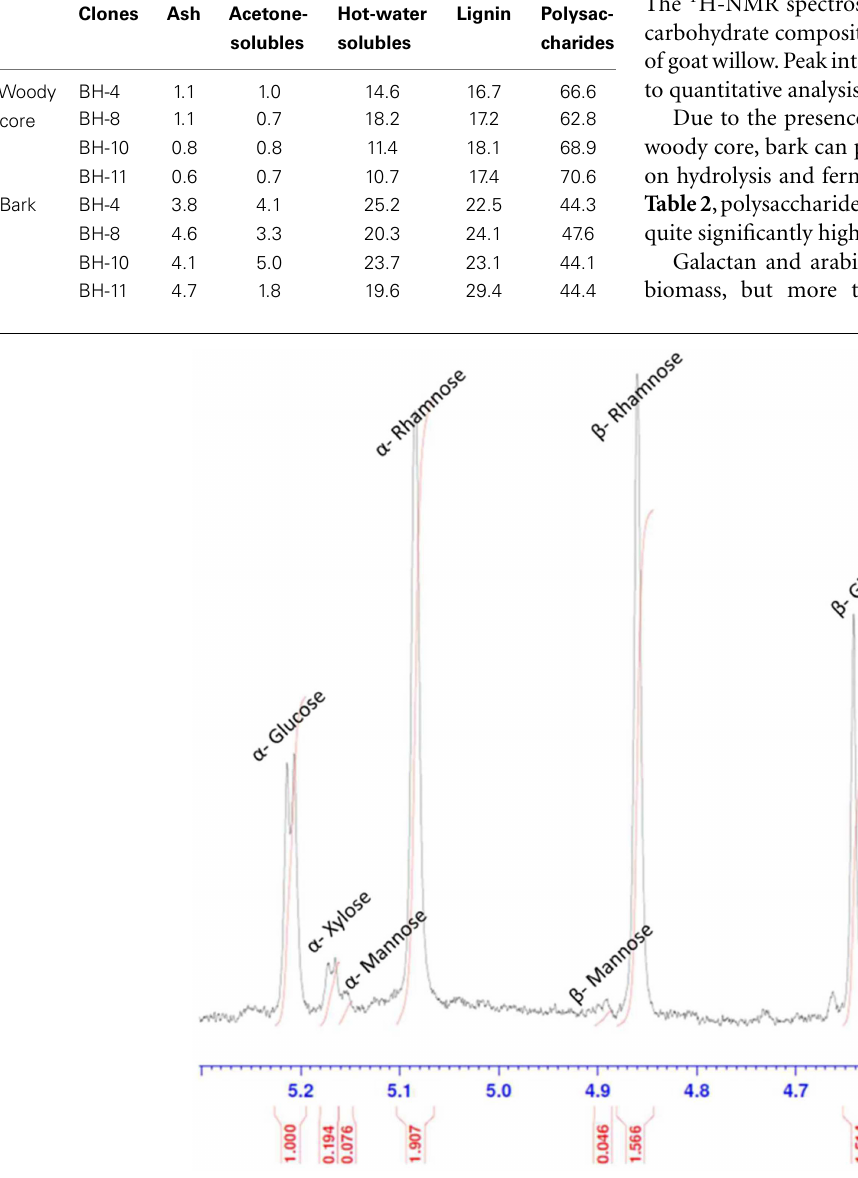
Table 1 | Overall chemical composition of different willow cultivar on wood and bark [unit: % (wt/wt)]. Clones Acetone-